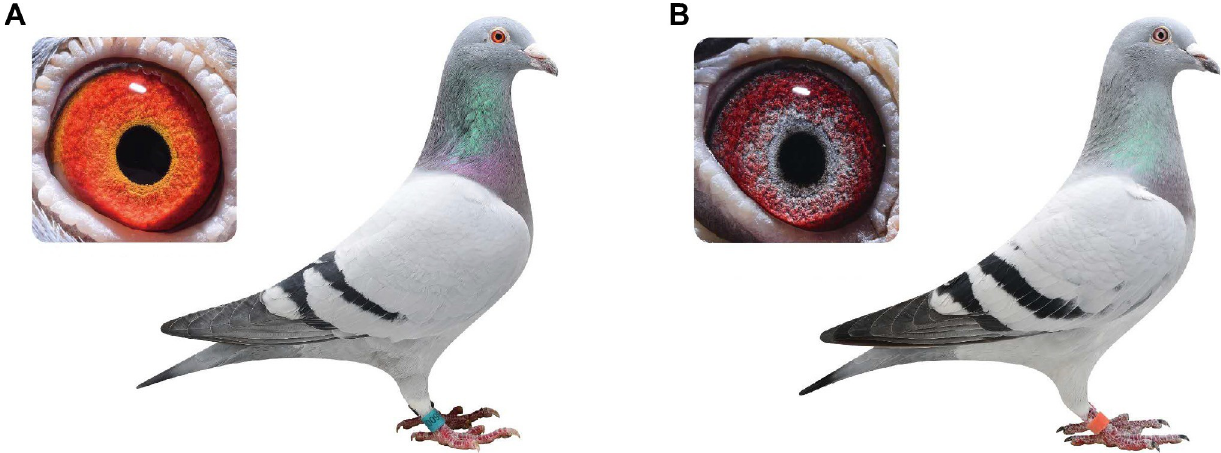
Fig 1. Iris color variation in domestic pigeons. (A) A pigeon with gravel eyes (wild type) exhibits a bright orange iris color; (B) A pigeon with pearl eyes exhibits a grayish-white iris color. The red background in both gravel and pearl irises is from capillaries. Photo credit: J. -O. Gao.